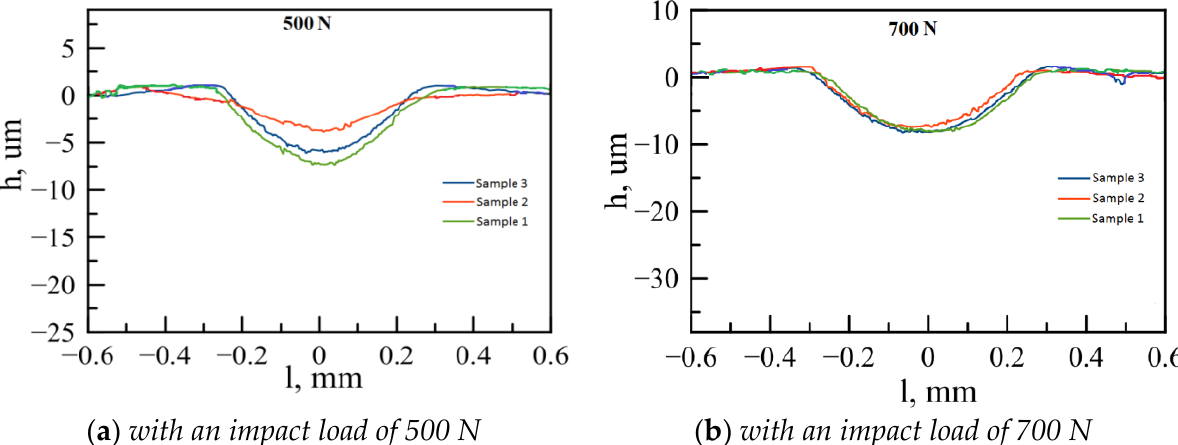
Figure 12. Profiles of the deformed surface of samples made of low-chromium cast iron as a result of cyclic impact-dynamic action.